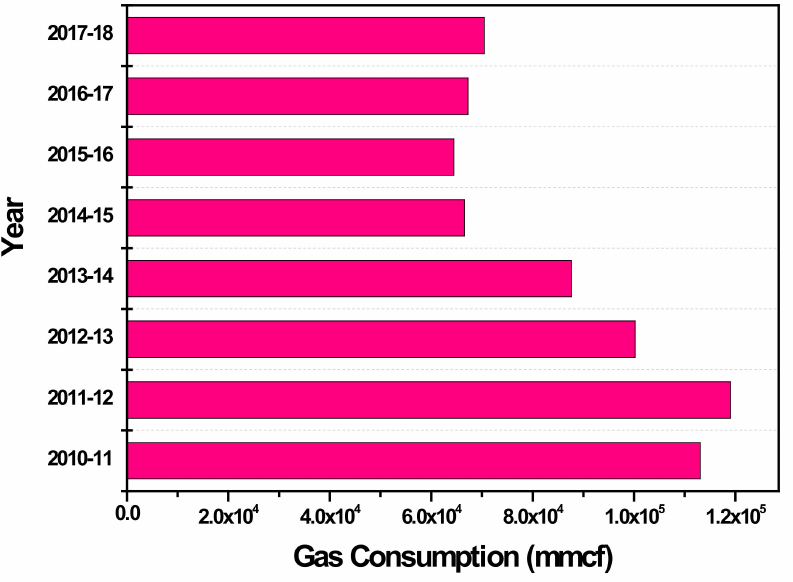
Figure 8. Consumption of gas (CNG) by the transport sector in Pakistan